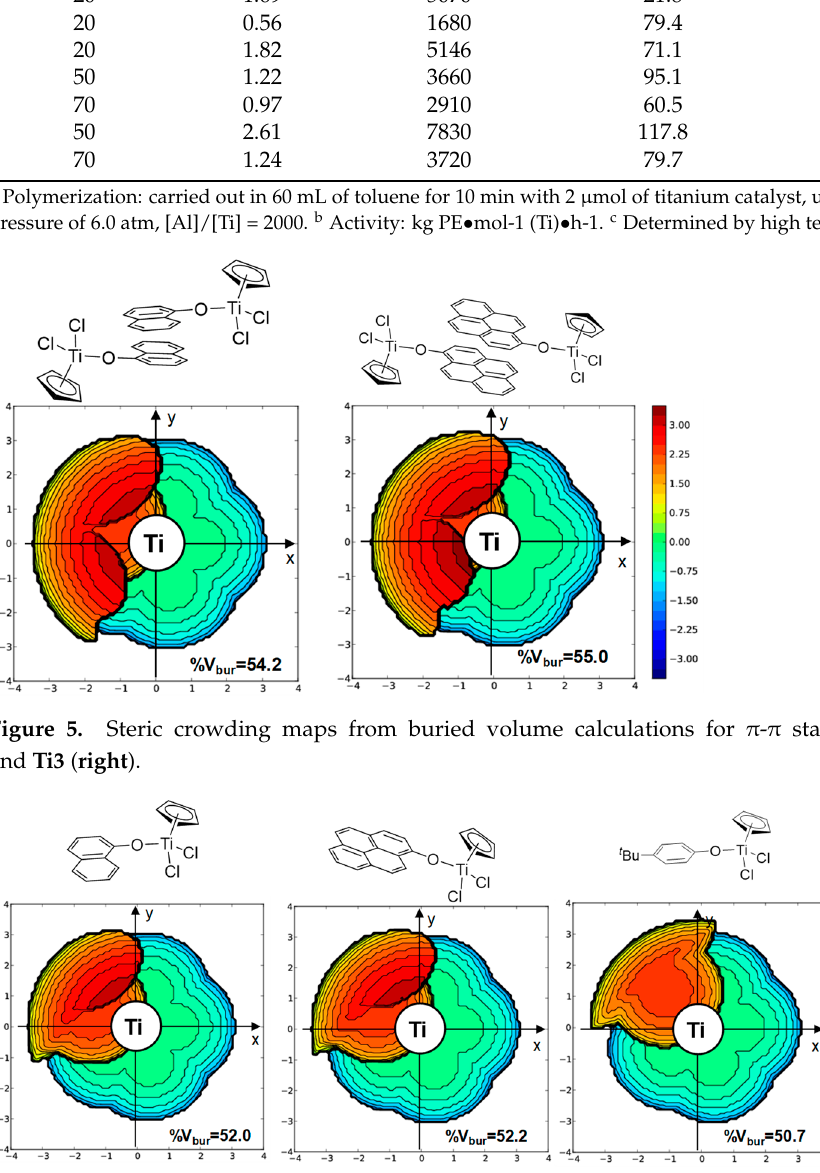
Table 1. Ethylene polymerization with Ti1 – Ti4 /DMAO catalytic systems a .